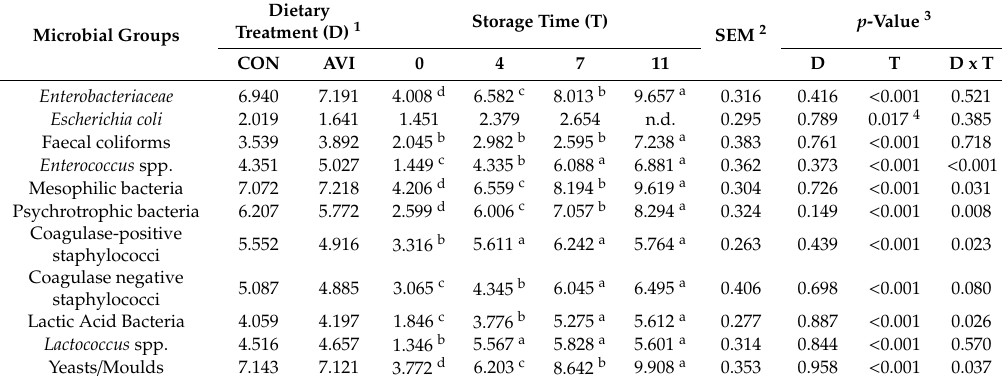
Table 4. E ff ect of dietary treatment on microbial counts (expressed as log 10 cfu / g) in raw meat during storage at refrigerated conditions.